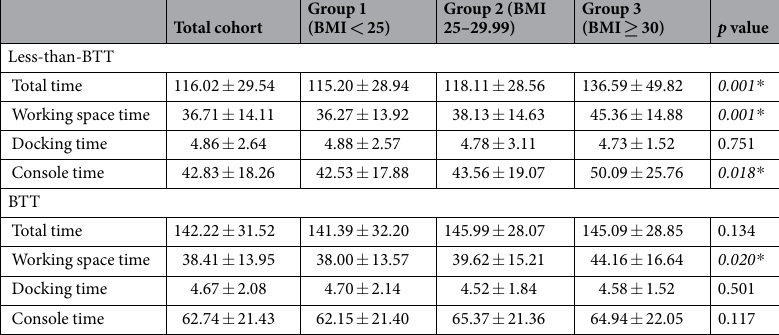
Table 4. Operative times across the three BMI groups. All times in minutes; BMI, body mass index in kg/m 2 ; BTT, bilateral total thyroidectomy; * statistically significant at p < 0.05.